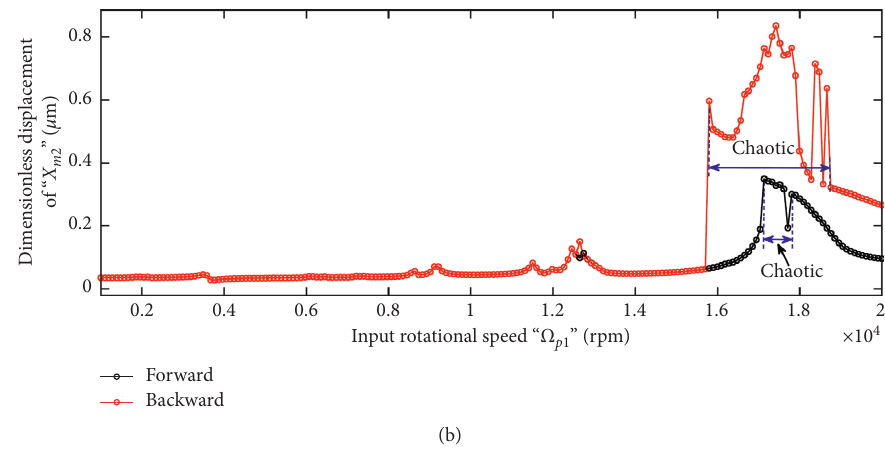
Figure 20: PPVs of forward and backward bifurcation system; s